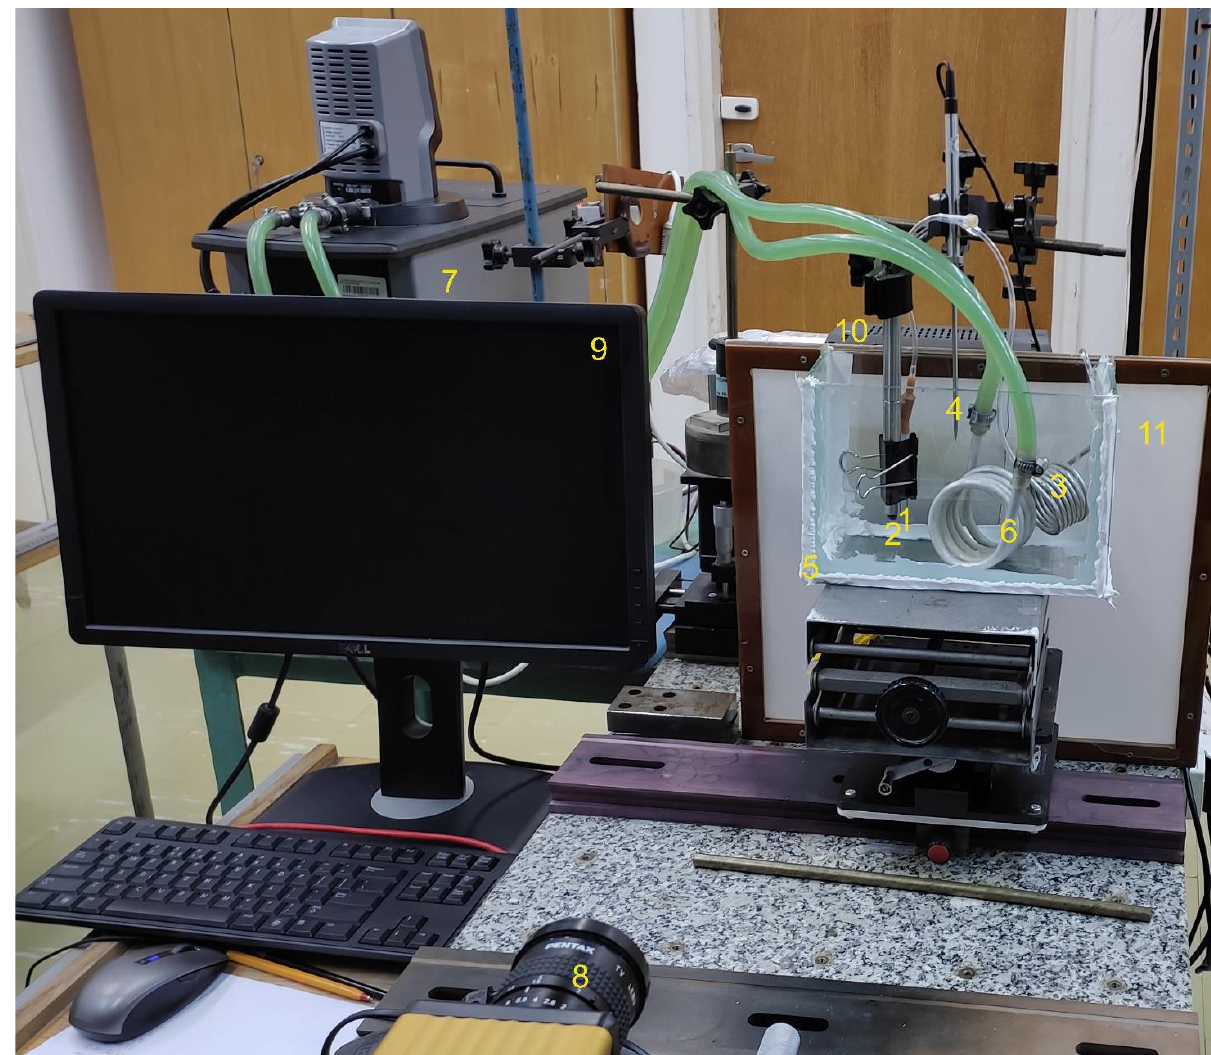
Figure 8. Applied system of apparatus: 1 — needle supplying water, 2 — the benchmark of a linear dimension, 3 — temperature equalizer, 4 — thermocouple K, 5 – octane (empty) tank sealed tightly with silicone, 6 — heat exchanger, 7 — circulating bath, 8 — CCD camera, 9 — monitor, 10 — photographic lamp, 11 — dispersion filter.